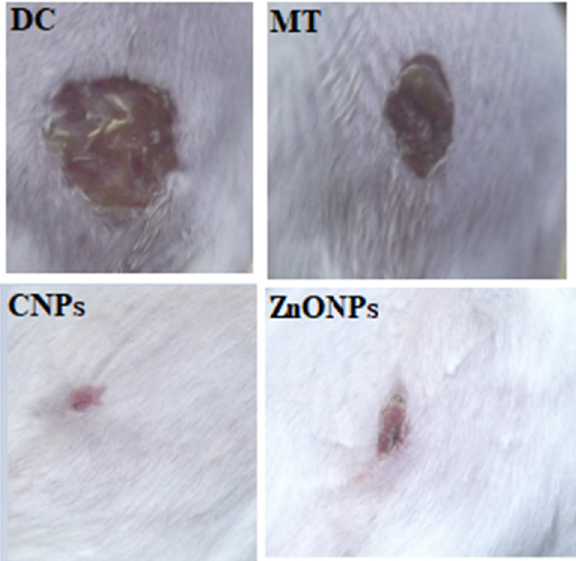
Figure 8: Images of wound closure in animals after lesioning ( DC ) and treatment with metformin ( MT ) , gold – silver nanocomposite ( CNPs ) , and zinc oxide nanoparticles ( ZnONPs ) at the end of the experimental